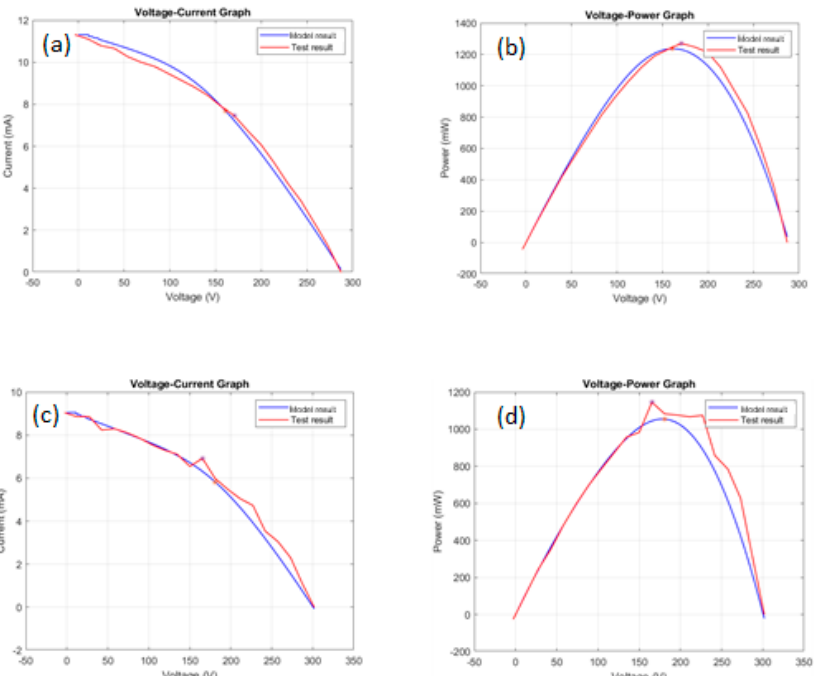
Figure 6. ( a ) I-V curve and ( b ) P-V curve comparisons of 5904 cm 2 module tested on 24 August 2018; ( c ) I-V curve and ( d ) P-V curve comparisons of 5904 cm 2 module tested on 29 October 2018. The maximum power point in each I-V/P-V waveform is highlighted as red or purple point, respectively.